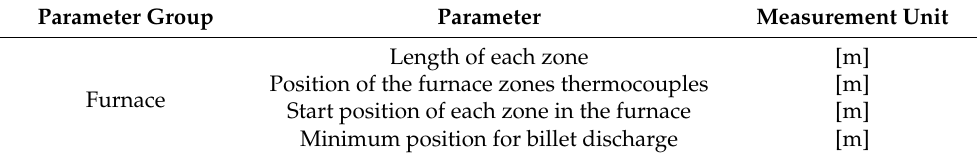
Table 4. Furnace